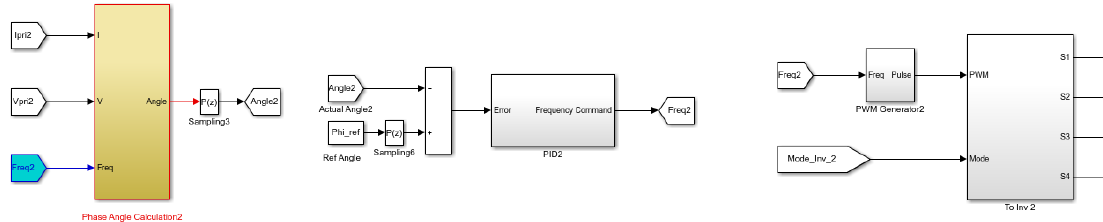
Figure A2. The control circuit of each inverter with PWM generation.